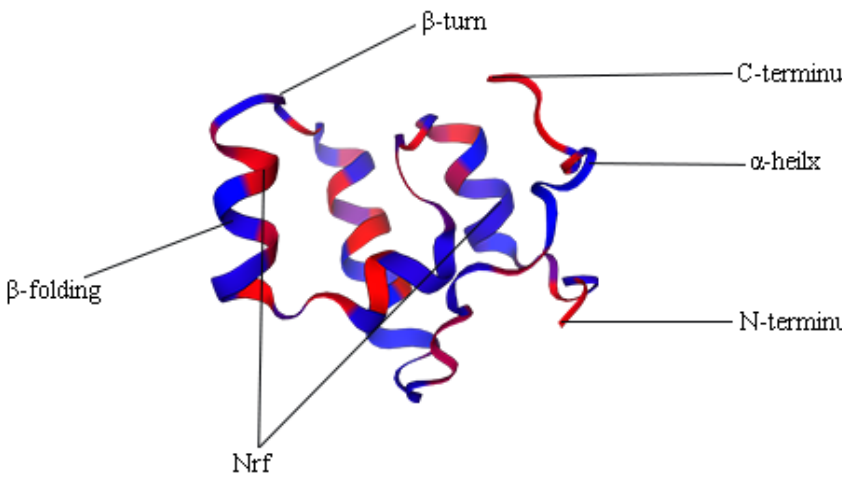
Figure 2. 3D structure domain of Nrf1a-1 .